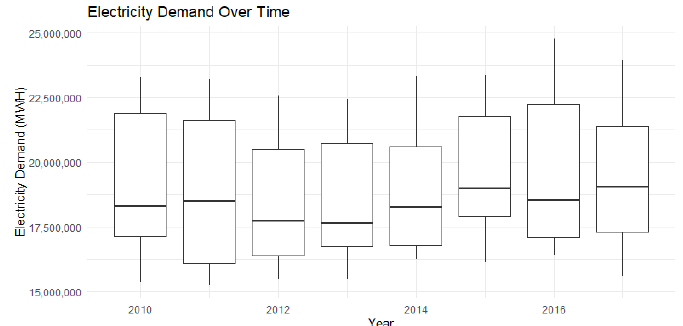
Figure 1. Box plot of electricity usage by